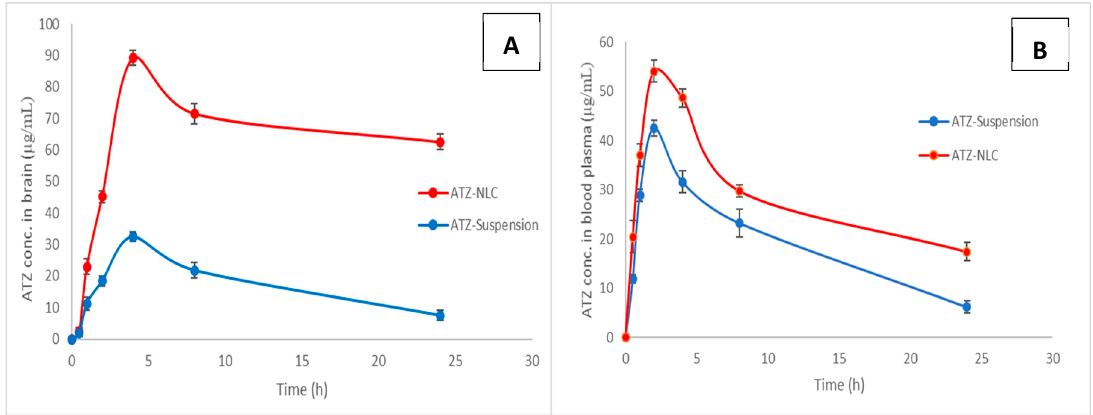
Figure 10. ATZ concentration in ( A ) brain and (B ) blood plasma.